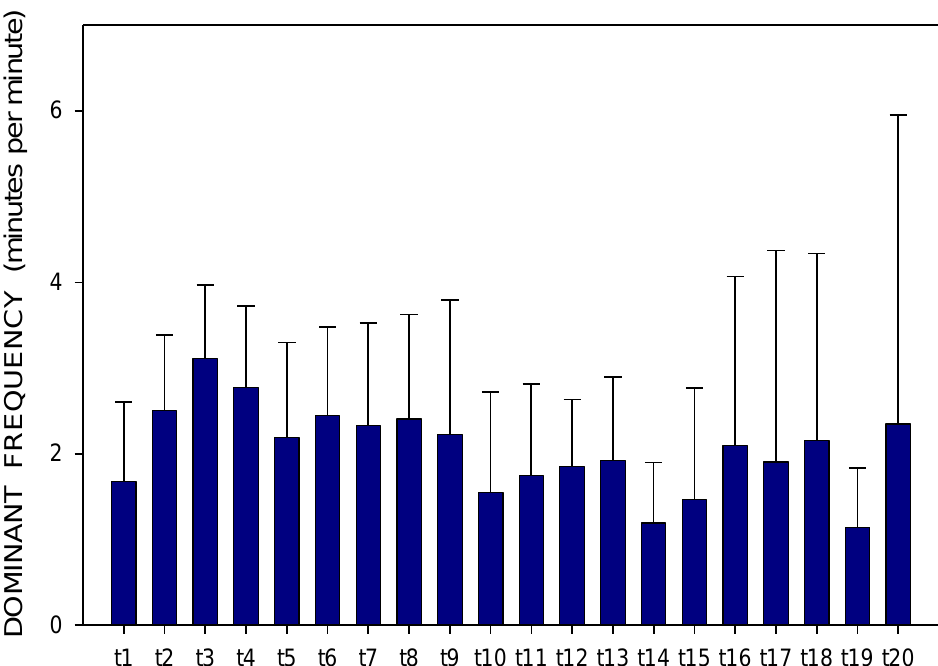
Figure 7. Electrogastrography. Dominant frequency in animals with a shorter small bowel transit time (272 ± 60 min); mean + standard deviation. Explanatory note: t: 15-min study recordings after galantamine administration (t1: time interval between 0–15 min ... t20: time interval between 286–300 min).